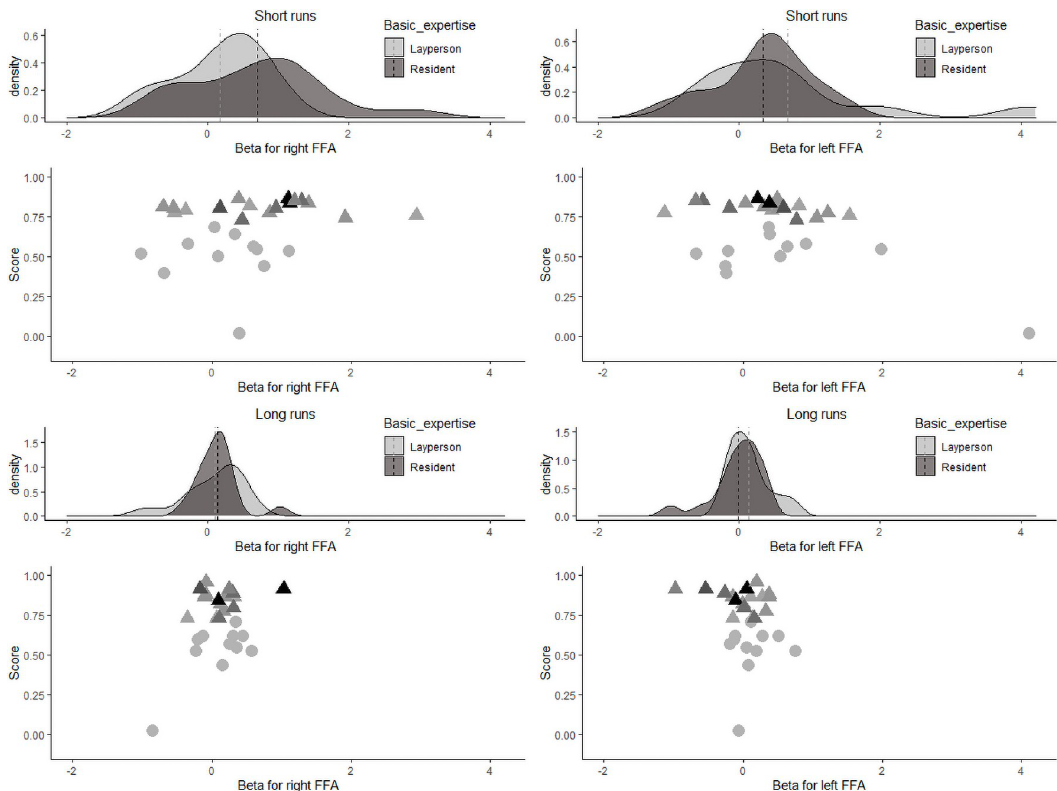
Fig 4. Density plots (upper panels) and scatter plots (lower panels) for the individual beta values in the FFA for short- and long-presentation trials. In the upper panels, the dotted line denotes the group mean. In the lower panels, for residents, darker colors depict more experienced